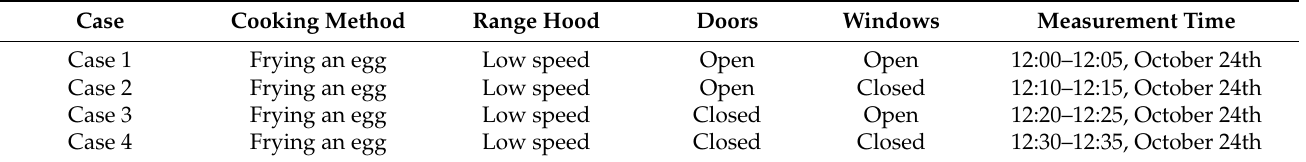
Table 2. Measurement condition